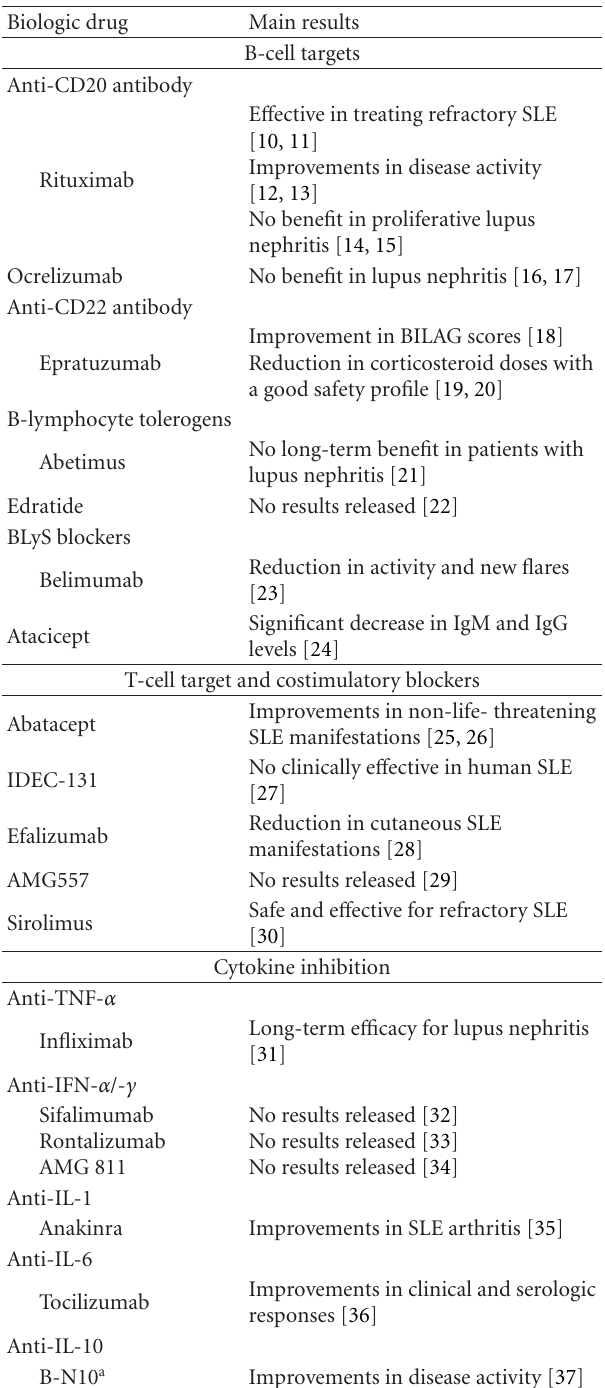
Table 1: Biological therapies proposed for SLE